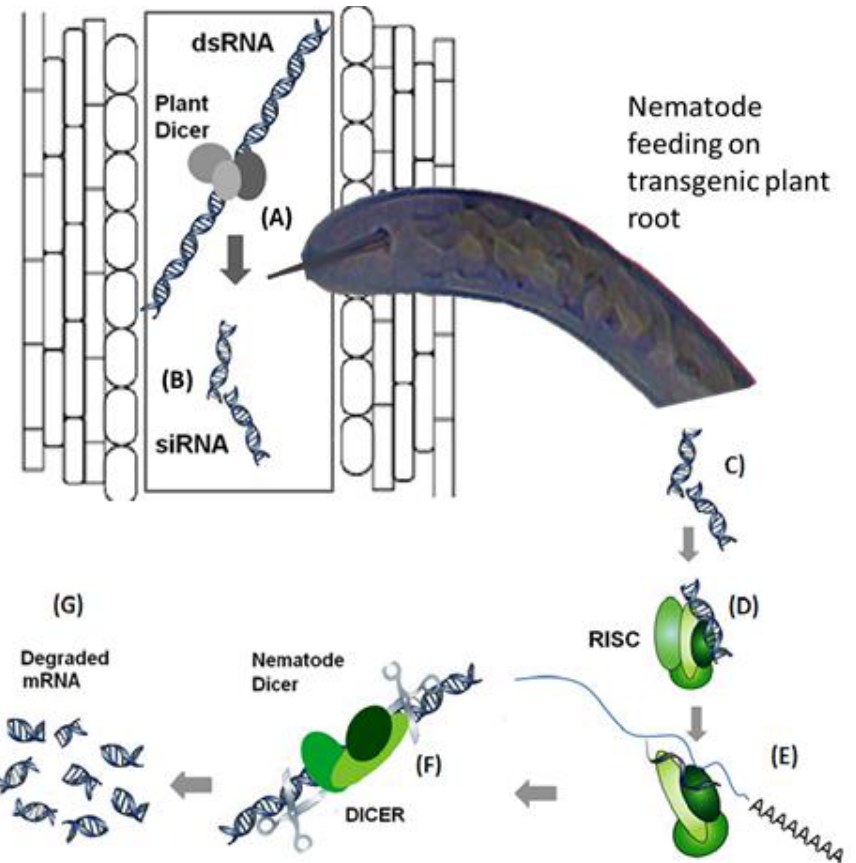
Figure 1. Host induced gene silencing for nematode resistance in plants. ( A ) and ( B ): Double stranded RNA (dsRNA) sequence of the target nematode effector gene is transformed into the plant which is cut by the plant DICER enzyme into small interfering RNAs (siRNAs). ( C ), ( D ) and ( E ): These siRNAs are taken up by the nematodes through their stylets which are detected by the RISC complex that binds to mRNA (complementary to the siRNA sequences) of the target effector gene. ( F ) and ( G ): This is followed by the activation of nematode DICER to cut the double stranded RNA to degrade the mRNA of the target nematode effector gene. Reproduced from Ali et al. [10].